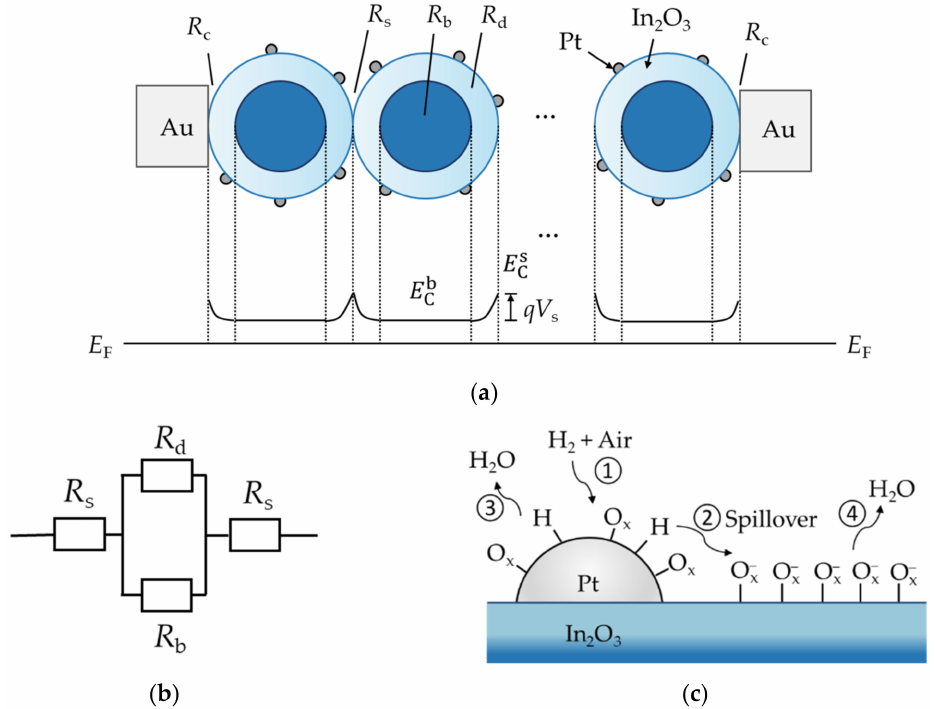
Figure 4. Schematic diagram of the Pt-In 2 O 3 resistive sensor. ( a ) Simplified structure and energy band diagram, where R c , R s , R b , and R d are the contact resistance between the metal electrode and the sensitive material, the surface resistance at the interface between In 2 O 3 particles, the bulk resistance inside the particle, and the resistance of the depletion region at the periphery of the particle, respectively; E F is the Fermi energy level, and E b and E s are the conduction bands of the bulk C C and surface of the In 2 O 3 particle, respectively. When the sensor is placed in an air atmosphere, O 2 naturally adsorbs on the surface of the In 2 O 3 , forming an upward bending of the surface energy band denoted as qV s ( V s < 0); ( b ) Composition of the resistance of an In 2 O 3 particle after simplification. ( c ) Schematic diagram illustrating the H 2 sensing mechanism of Pt-In 2 O 3 . Here, 1 (cid:13) , 2 (cid:13) , 3 (cid:13) , and 4 (cid:13) represent the dissociative adsorption process of hydrogen at Pt, the spillover process, the direct reaction with adsorbed oxygen species on Pt to produce water vapor, and the reaction with adsorbed oxygen species on the surface of In 2 O 3 to produce water vapor and release electrons, respectively; O x and O − x represent the possible oxygen species adsorbed on Pt and In 2 O 3